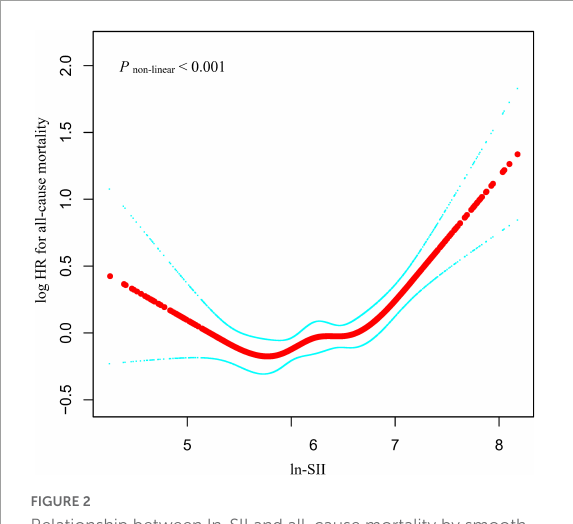
FIGURE2 Relationship between ln-SII and all-cause mortality by smooth curve fitting. Adjustment for sex, age, body mass index (BMI), ethnicity, waist circumference, education level, marital status, family poverty income ratio, alcohol user, smoke, malignancy, stroke, asthma, diabetes, hypertension, albumin, estimated glomerular filtration rate (eGFR), alanine aminotransferase (ALT), aspartate aminotransferase (AST), total cholesterol, hemoglobin A1c (HbA1c), high-density lipoprotein (HDL) cholesterol, creatinine, and uric acid. The red line demonstrates the risk of mortality, and the blue dotted lines illustrate its 95% confidence interval (CI).